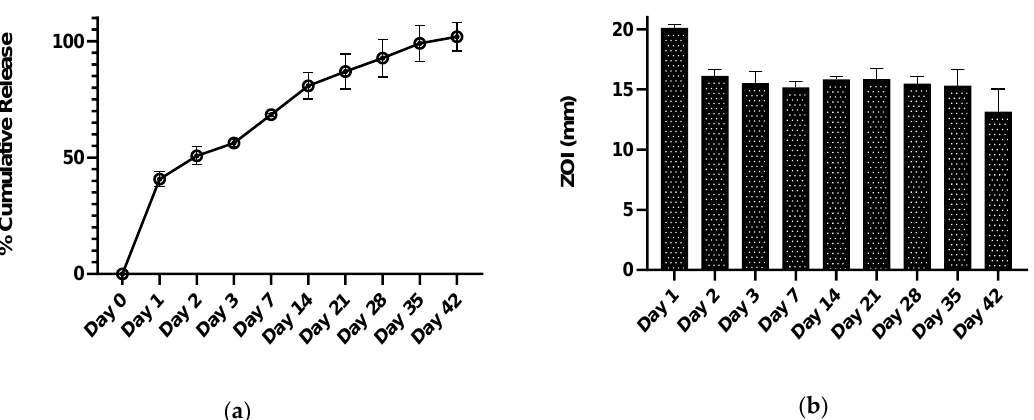
Figure 3. ( a ) Drug release kinetics of vancomycin from the ABVF putty shows drug release for up to 42 days (6 weeks). ( b ) The bioactivity of released vancomycin was determined via a Kirby Bauer zone of inhibition study against Staphylococcus aureus (strain ATCC 49230: 1.0 × 10 7 CFU / mL).